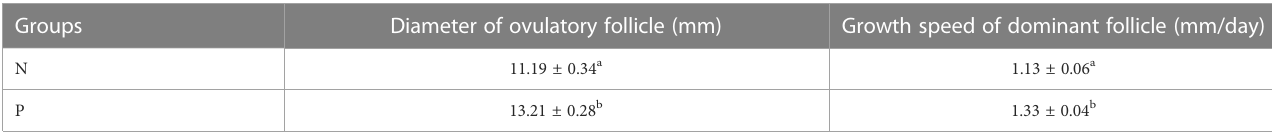
TABLE 3 Diameter of ovulatory follicles and growth speed of dominant follicle between antibody-positive and antibody-negative buffaloes. Groups